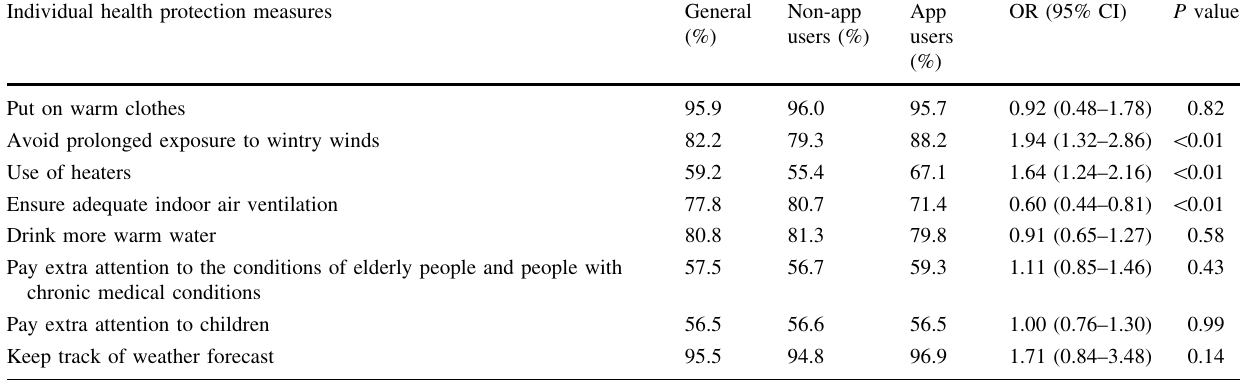
Table 3 Practice of individual health protection measures during the 2016 Hong Kong cold wave Individual health protection measures